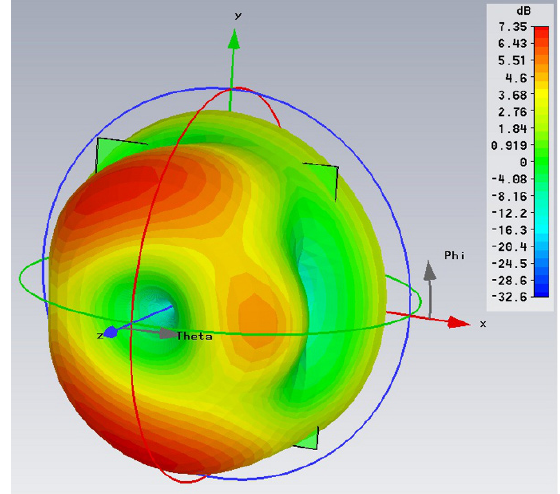
Figure 10. Radiation pattern for